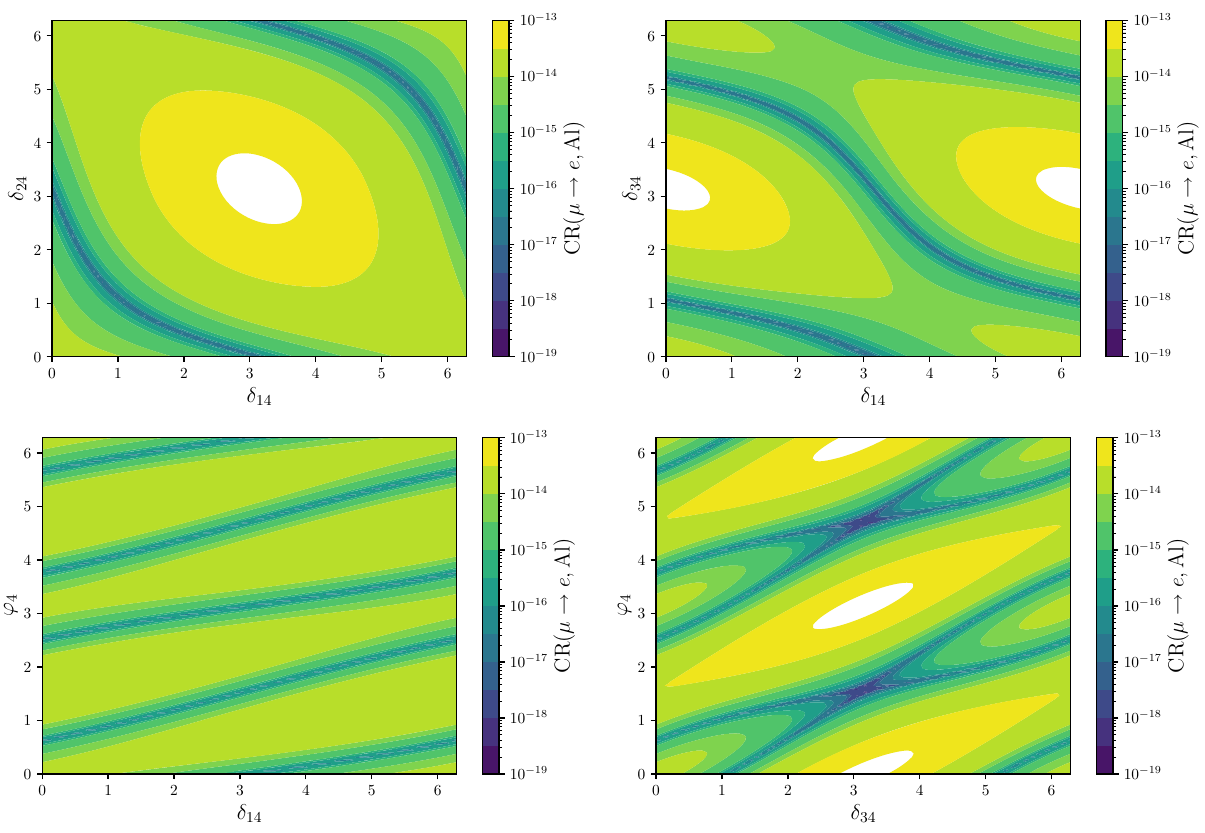
Fig. 9 Contour plots for cLFV μ − e conversion in Aluminium, for fixed values of the degenerate heavy sterile mass, m 4 = m 5 = 1 TeV, for θ = 10 − 3 , θ = 0 . 01 and θ = 0 . 1 ( j = 4 , 5) and varying CPV phases: on the top row, spanned by pairs of Dirac phases, (δ 1 j 2 j 3 j (δ − δ ) , respectively left and right panels; bottom row, spanned by Dirac-Majorana phases, (δ 14 34 panels. The colour scheme denotes the associated value of CR( μ − e , Al) as indicated by the colour bar to the right of each plot (white regions denote CR( μ − e , Al) > 10 − 13 )